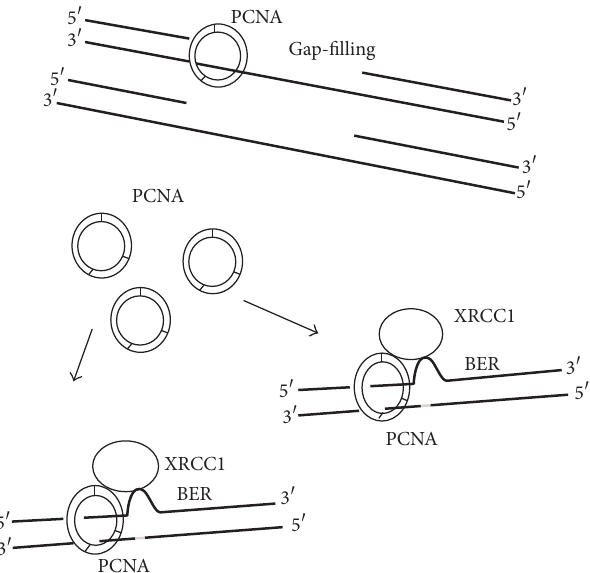
Figure 9: PCNA is important to the gap-filling during the repair of UV-induced DNA injuries and is also essential to the repair of oxidative DNA lesions. When oxidative DNA damage increases or XRCC1 overexpresses, more PCNA is recruited to BER, which may leave more gaps